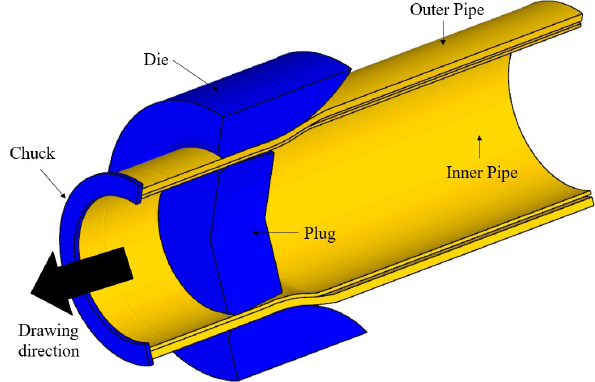
Table 1. Result of average surface roughness.